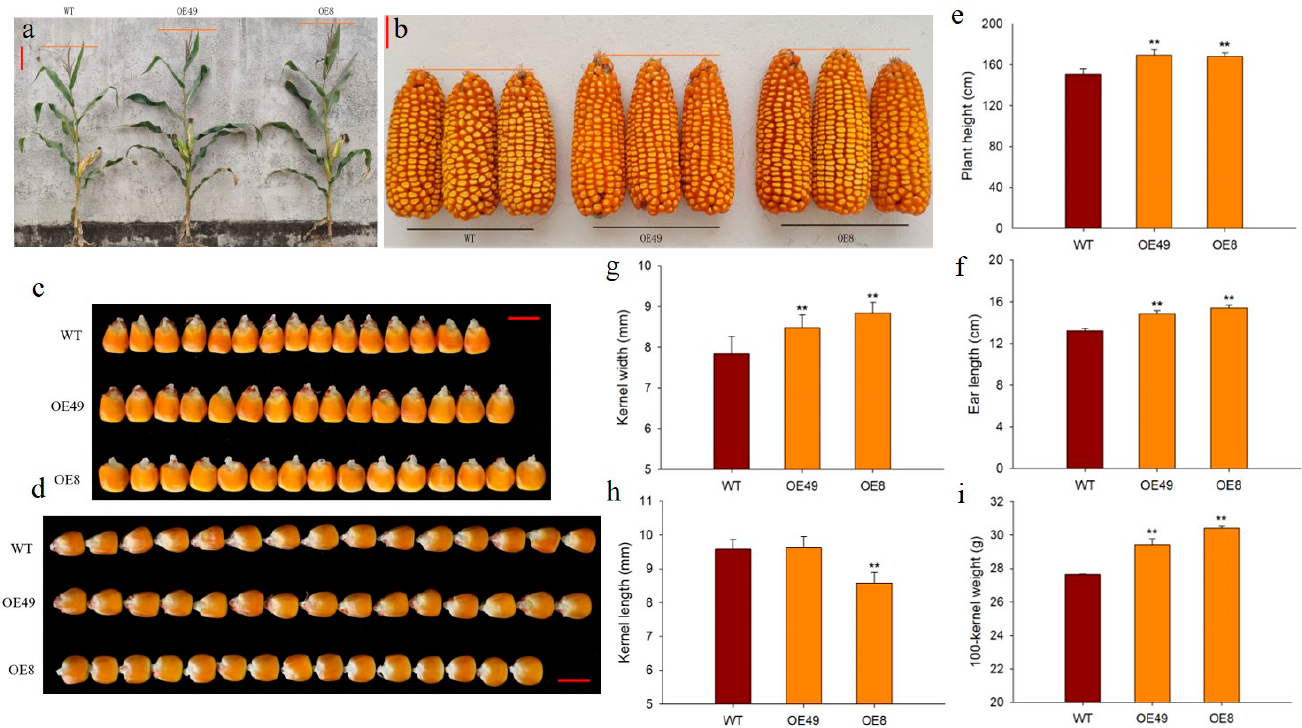
Figure 4. Phenotypic analysis of ZmCYCB1-1 overexpression lines. ( a , e ) Plant height of the WT and ZmCYCB1-1 overexpression plants. ( b , f ). Ear length of the WT and ZmCYCB1-1 overexpression plants. ( c , g ) Kernel width of the WT and ZmCYCB1-1 overexpression plants. ( d , h ) Kernel length of the WT and ZmCYCB1-1 overexpression plants. ( i ) 100-kernel weight of the WT and ZmCYCB1-1 overexpression plants. Scale bars are 10 cm in ( a ), 3 cm in ( b ), and 1cm in ( c , d ). Student’s t test, ** p < 0.01.